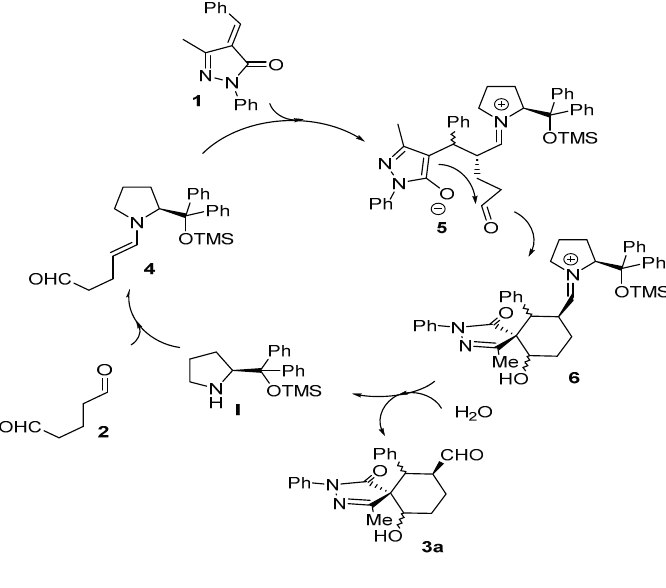
Figure 3. Proposed